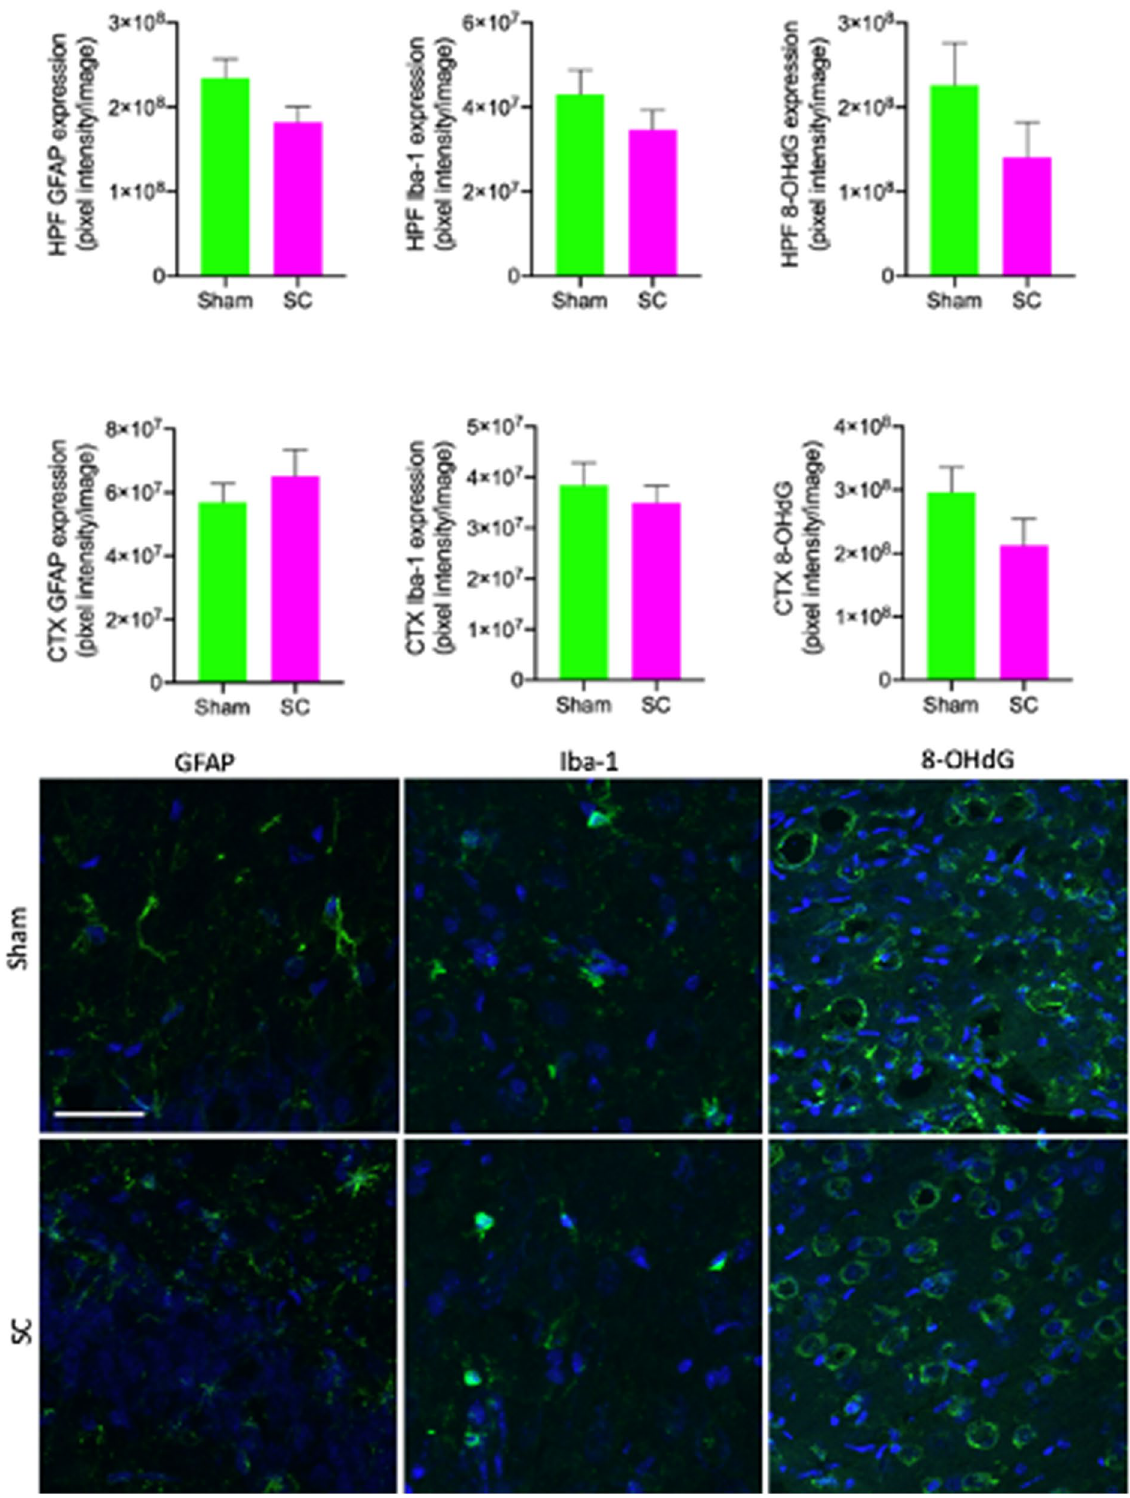
Figure 5. Neuroinflammation and oxidative stress in hippocampal formation and cortex. The markers of neuroinflammation (GFAP and Iba-1) and oxidative stress (8-OHdG) were semi-quantitatively measured in the hippocampal formation (HPF) and cortex (CTX) of sub-concussion rats (SC) and sham group. The data is shown as the mean pixel intensity per image with SEM. Statistical significance was assessed with two-tailed t-test at p < 0.05 (n = 8). Representative immunofluorescent micrographs are presented in the lower frame (scale bar = 40 µm). GFAP, Iba-1 and 8-OHdG are shown in green, while the nuclei DAPI staining is shown in